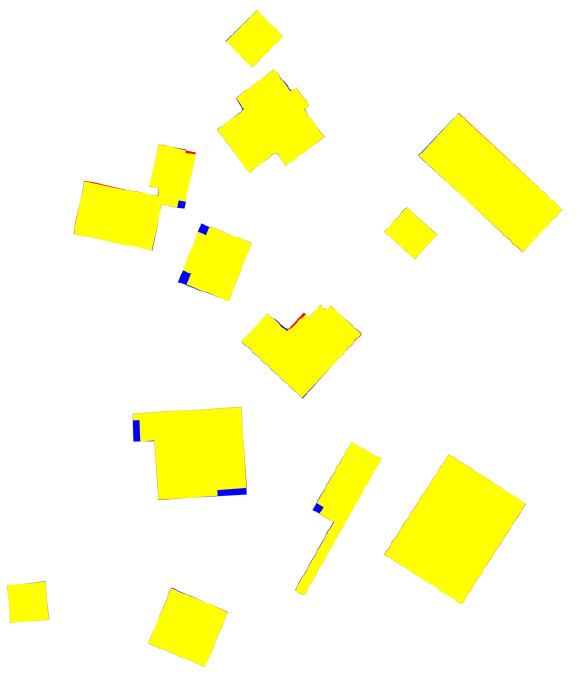
Figure 6. The extracted building outlines obtained by the raster approach from a point cloud with a density of 1 cm (meaning of colours: yellow – true positives; blue – false negatives; red – false positives).